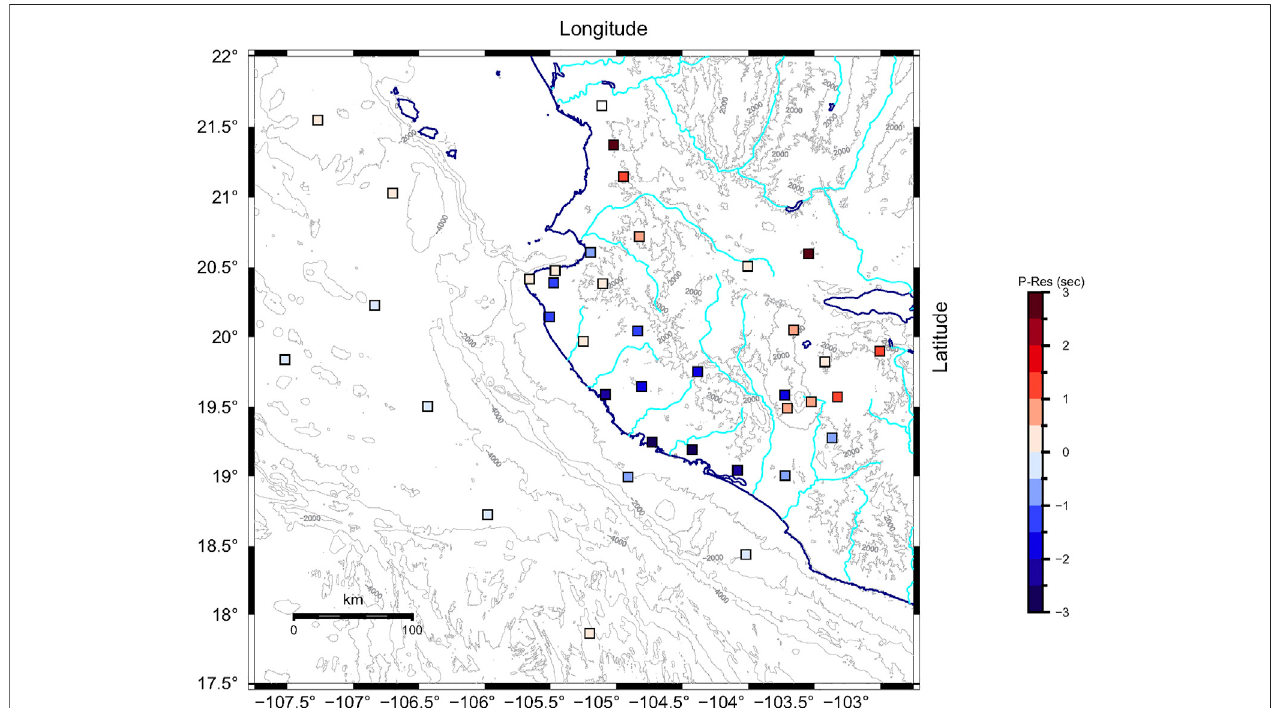
FIGURE 6 | P-wave residuals for the OBS, RESAJ, and TN stations from Hypo71 locations using OBS data and model SVR01.